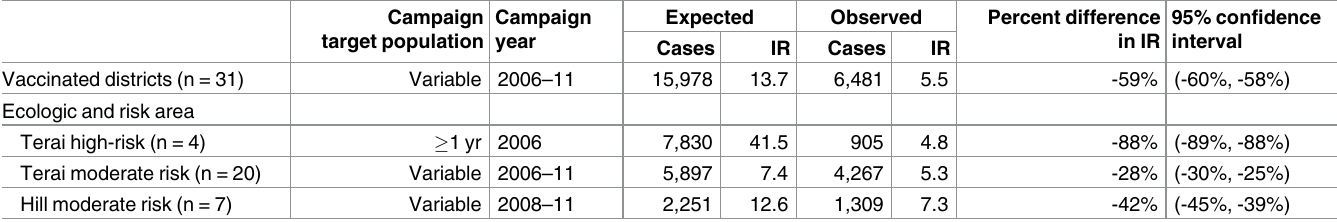
Table 3. Acute encephalitis syndrome expected and observed cases and incidence rates (IR) per 100,000person years in